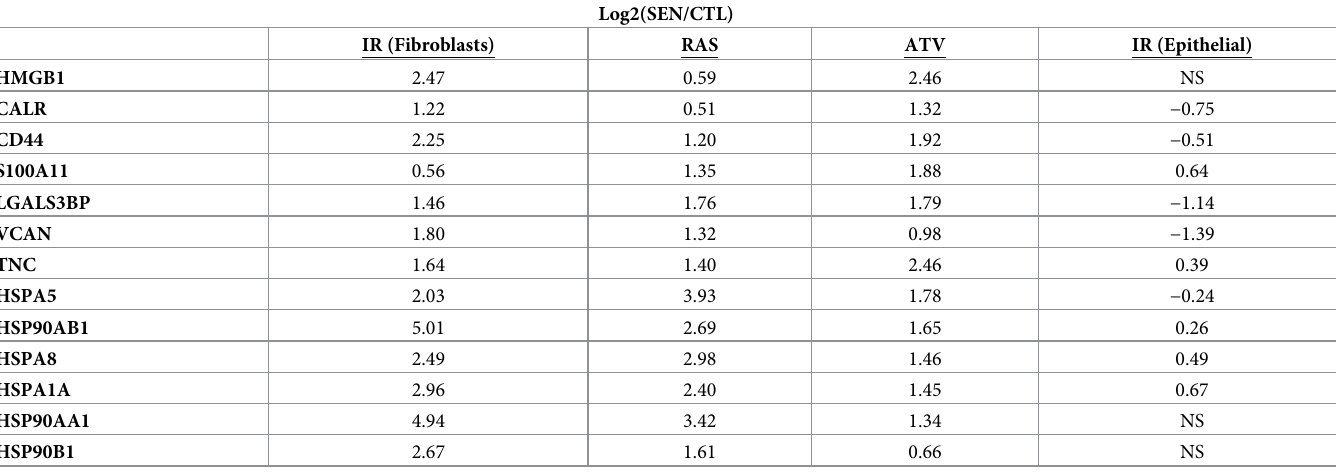
Table 1. DAMPs are a core component of the fibroblast sSASP.